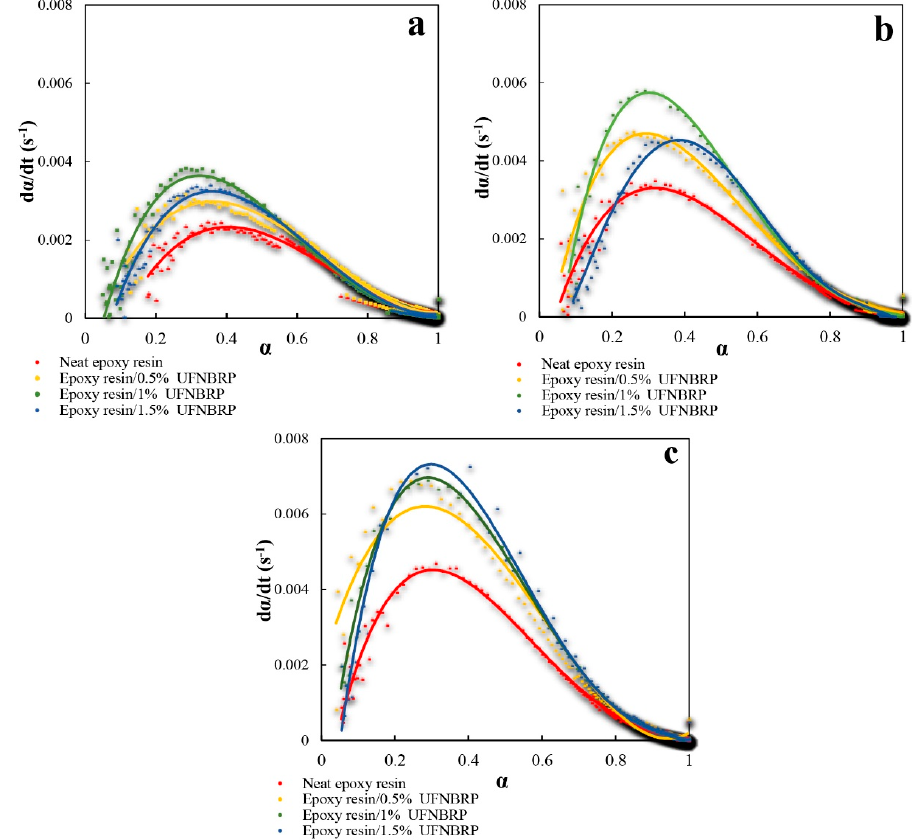
Figure 8. Variation in the curing rate of epoxy resin/UFNBRP nanocomposites at different tempera- tures of ( a ) 65 ◦ C, ( b ) 70 ◦ C, and ( c ) 75 ◦ C.